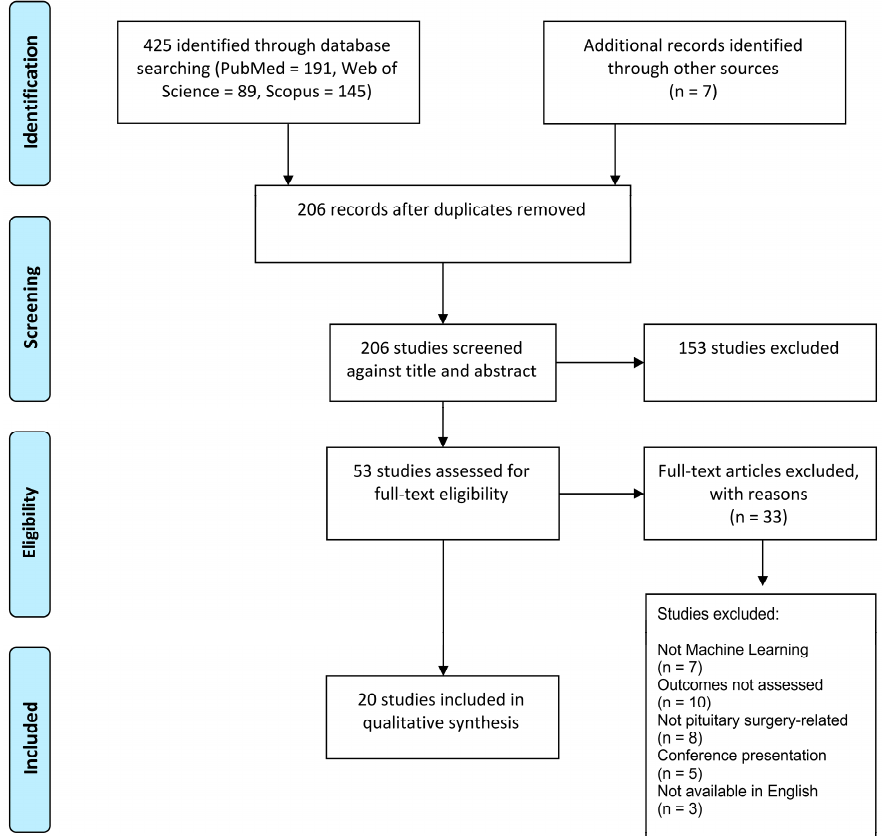
Figure 1. PRISMA flowchart of study search and inclusion process. PRISMA = Preferred Reporting Figure 1. PRISMA fl owchart of study search and inclusion process. PRISMA = Preferred Reporting Items for Systematic Reviews and Items for Systematic Reviews and Meta-analyses .